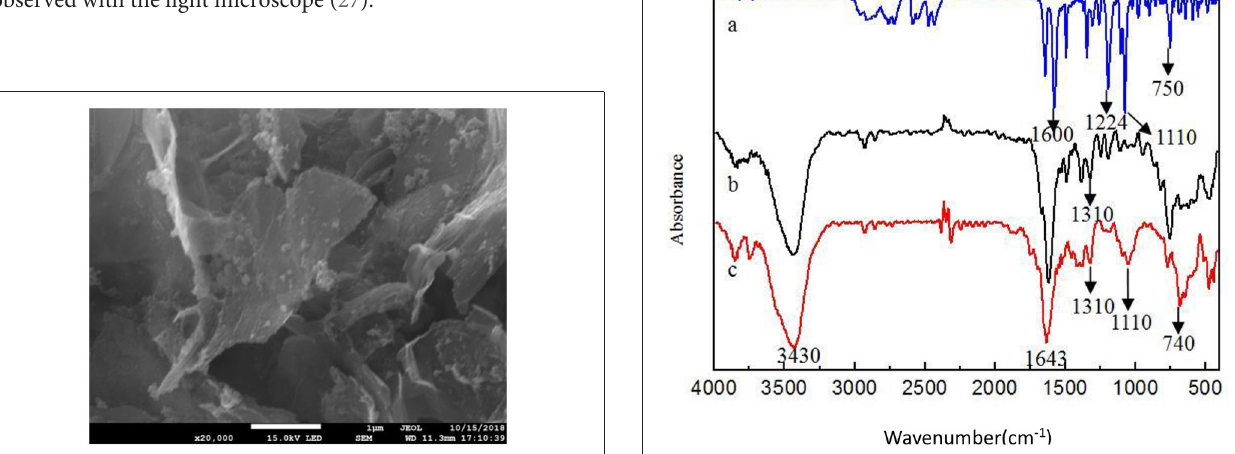
FIGURE 1 | SEM of Fe 3 O 4 -GO